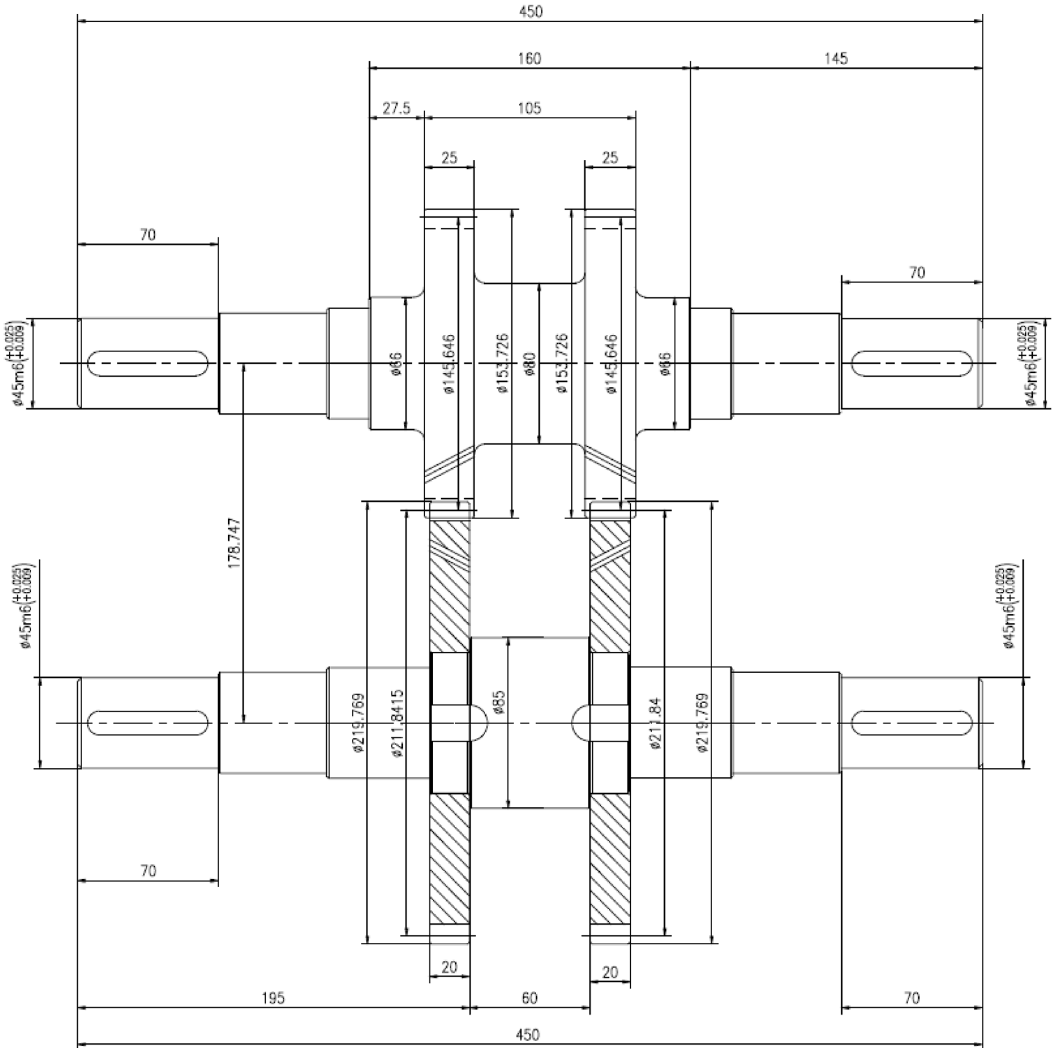
Fig. 5. Drawing of experimental pinion and gear.